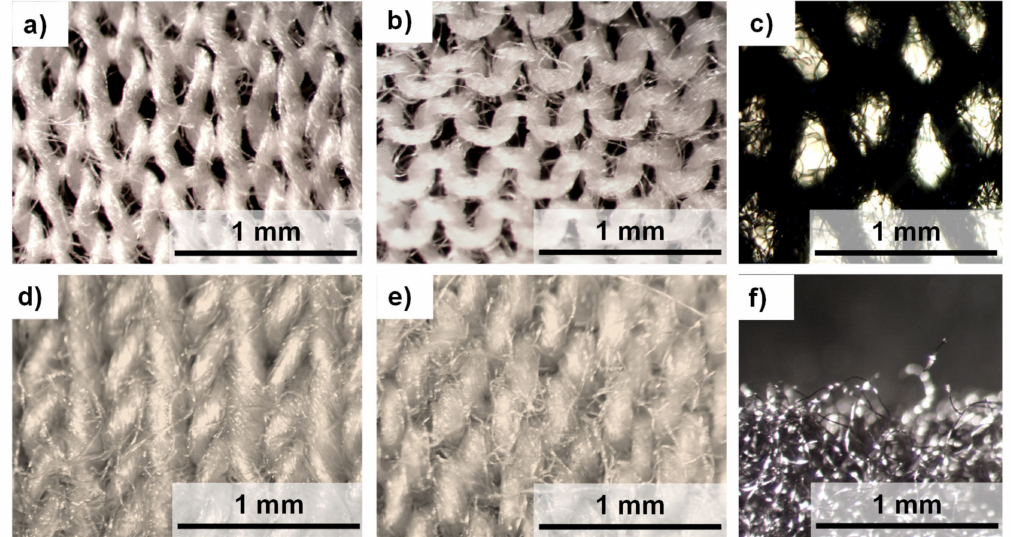
Figure 1. Optical microscopy images of knitted fabric made of Cotton LM (( a )—right side, ( b )—left side), knitted fabric made of Cotton HM (( c )—right side, ( d )—left side), brushed knitted fabric made of PES (( e )—right side, ( f )—brushed part (side